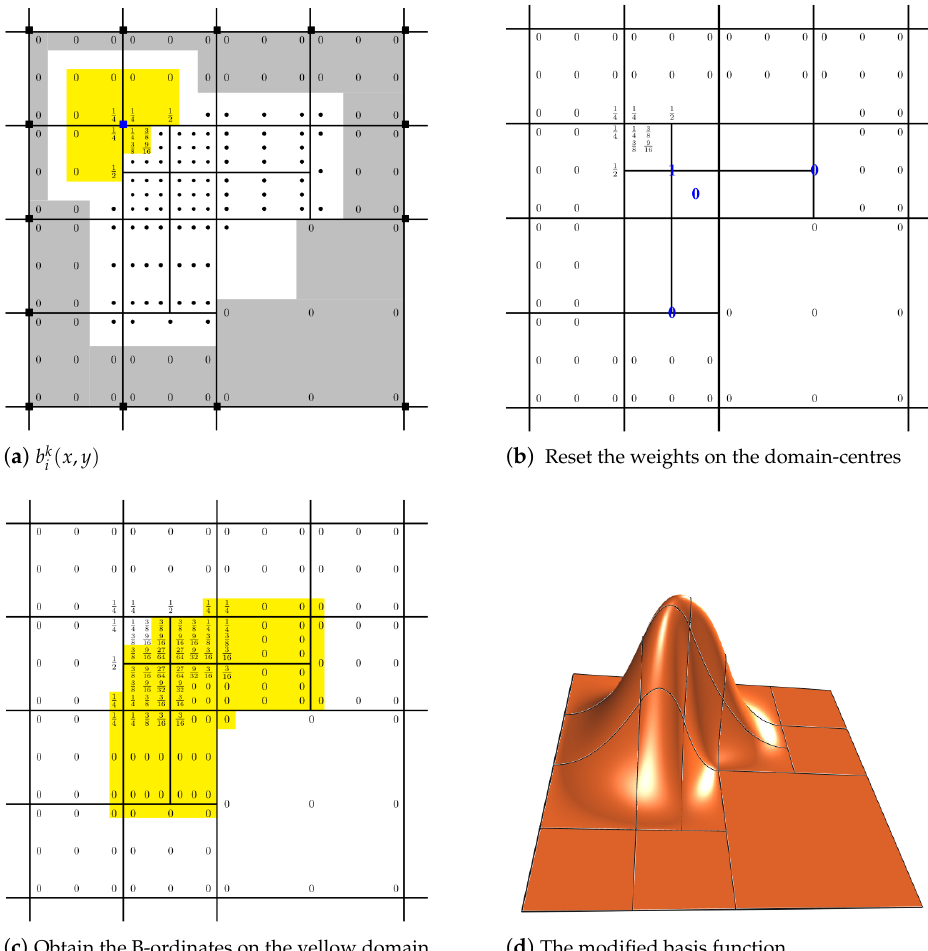
Figure 15. Basis modification. The values in the highlight domain of ( a ) are the reserved B-ordinates. “ (cid:4) ”in ( a ) denotes the crossing vertex. 0 and 1 in ( b ) denotes the reset weights. The values in the highlight domain of ( c ) are the new evaluated B-ordinates on the domain points that corresponds to the “ • ” in ( a